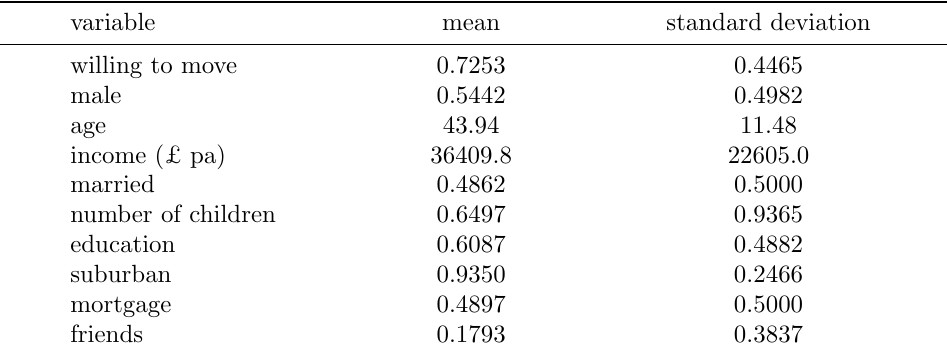
Table 1: Descriptive